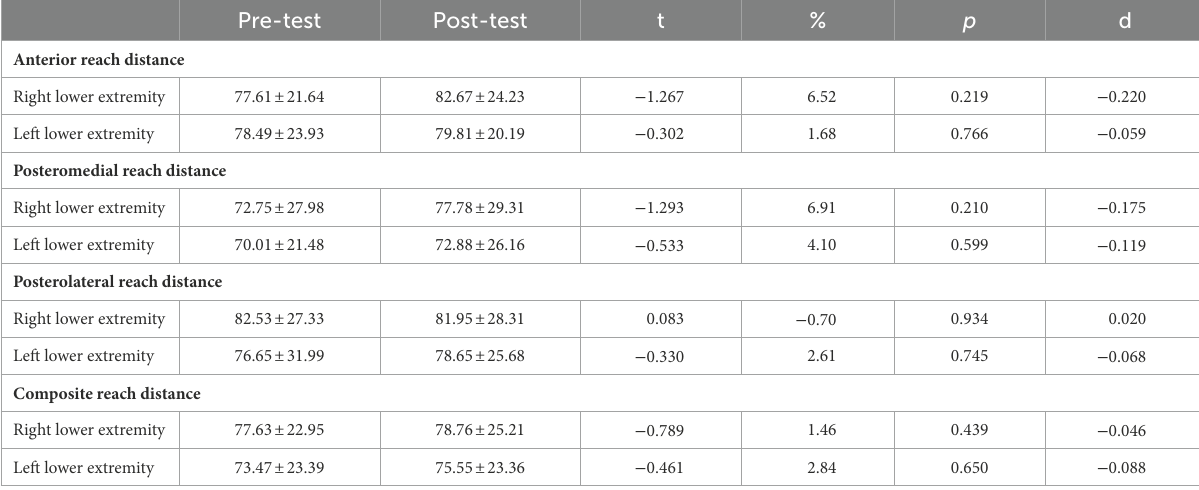
TABLE 6 Paired group T -test results conducted to determine whether there is a significant difference between the control group balance motor performance capacity pre–post-test Y Balance Test ANT, PM, PL and Composite reach distance mean